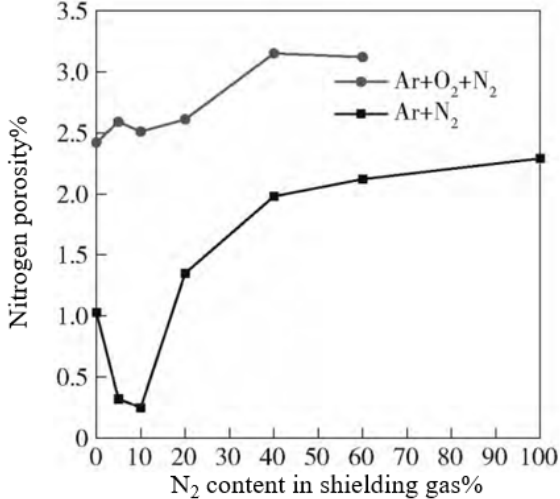
Figure 3. Effect of different N 2 contents in the shielding gas on the porosity in welding. Reprinted with permission from ref. [17]. Copyright 2019, Acta Armamentarii.